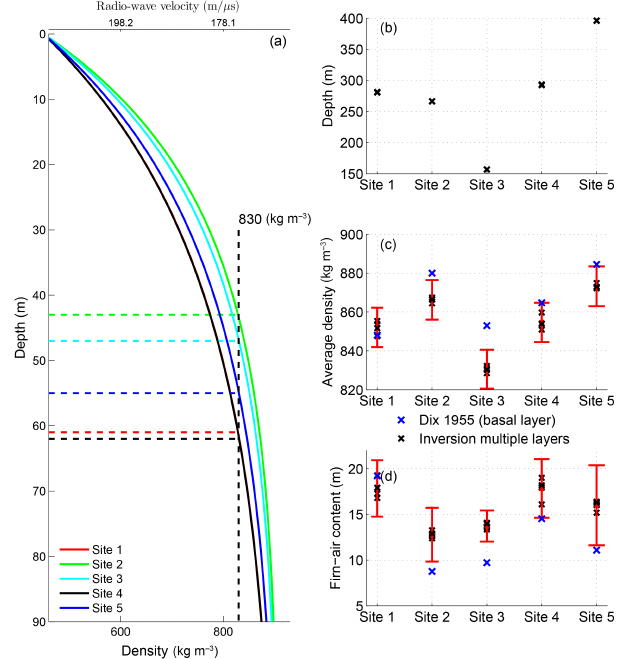
Figure 6. Derived data summary of all sites (Site 3 is located in an ice-shelf channel): (a) depth–density profiles inverted from four reflectors, (b) ice thickness, (c) depth-averaged density, and (d) firn- air content. Black crosses in (b–d) represent the outcomes for five combinations containing three or more reflectors. Error bars assume a 1% error in depth-averaged radio-wave propagation speed. The blue crosses correspond to depth-averaged solutions using normal moveout of the basal reflector only (Dix, 1955).